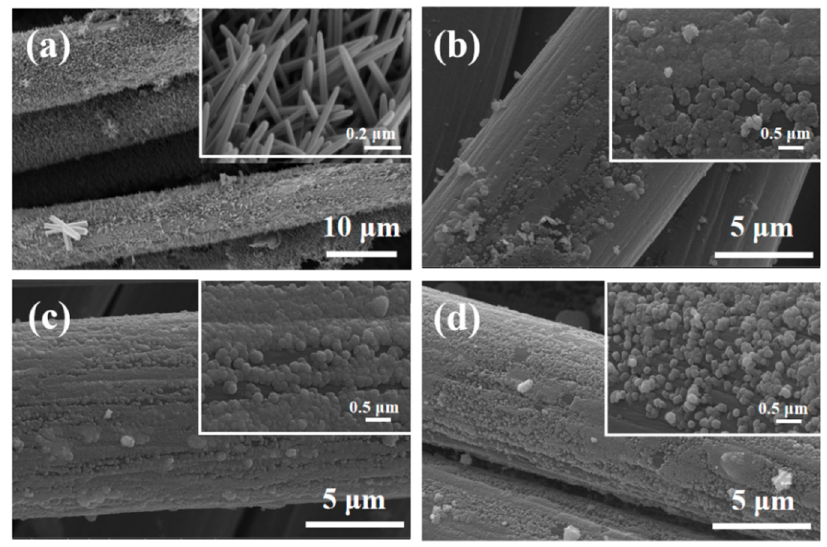
Figure 3. SEM of ( a ) ZnO–CC, ( b ) Z10CdSe–CC, ( c ) Z20CdSe–CC, and ( d ) Z30CdSe–CC.